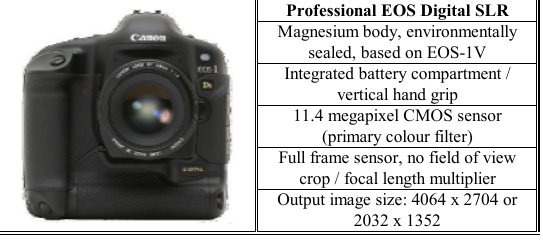
Table1. Camera properties. (Samadzadegan et al., 2004)